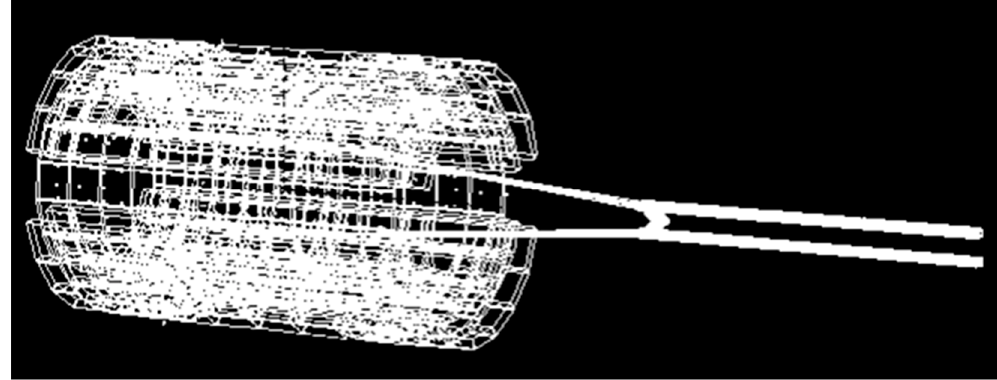
Figure 8. Snapshot of 3D view of the complete launch system: compulsator plus launcher at the instant of firing.